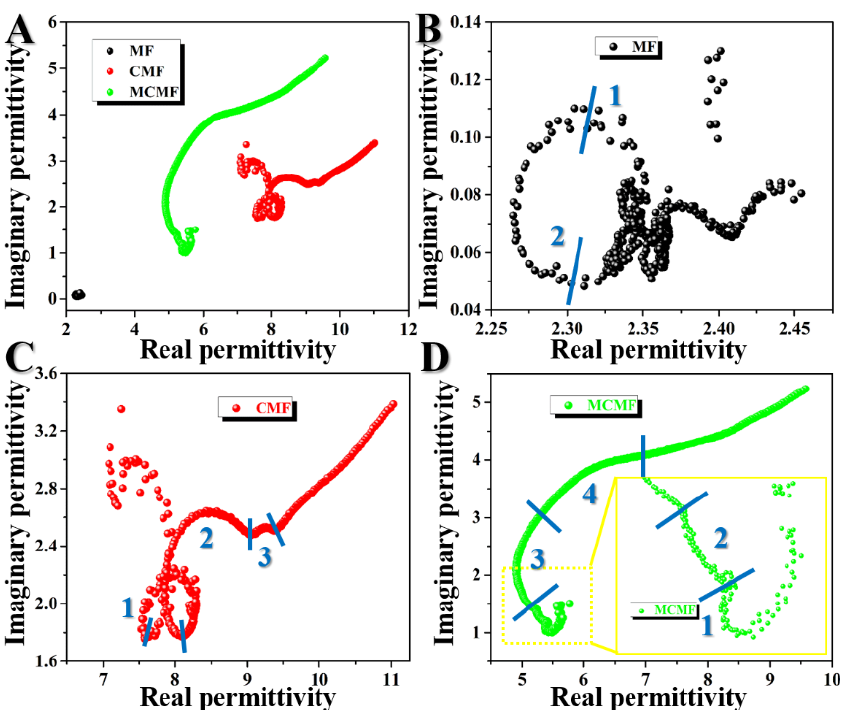
Figure 7. ( A ) Survey of the plots of (cid:2013) (cid:4593) vs. (cid:2013) (cid:4593)(cid:4593) for MF, CMF and MCMF. Typical Cole–Cole semicircles of ( B ) MF, ( C ) CMF and ( D ) MCMF. ( B ) MF, ( C ) CMF and ( D )